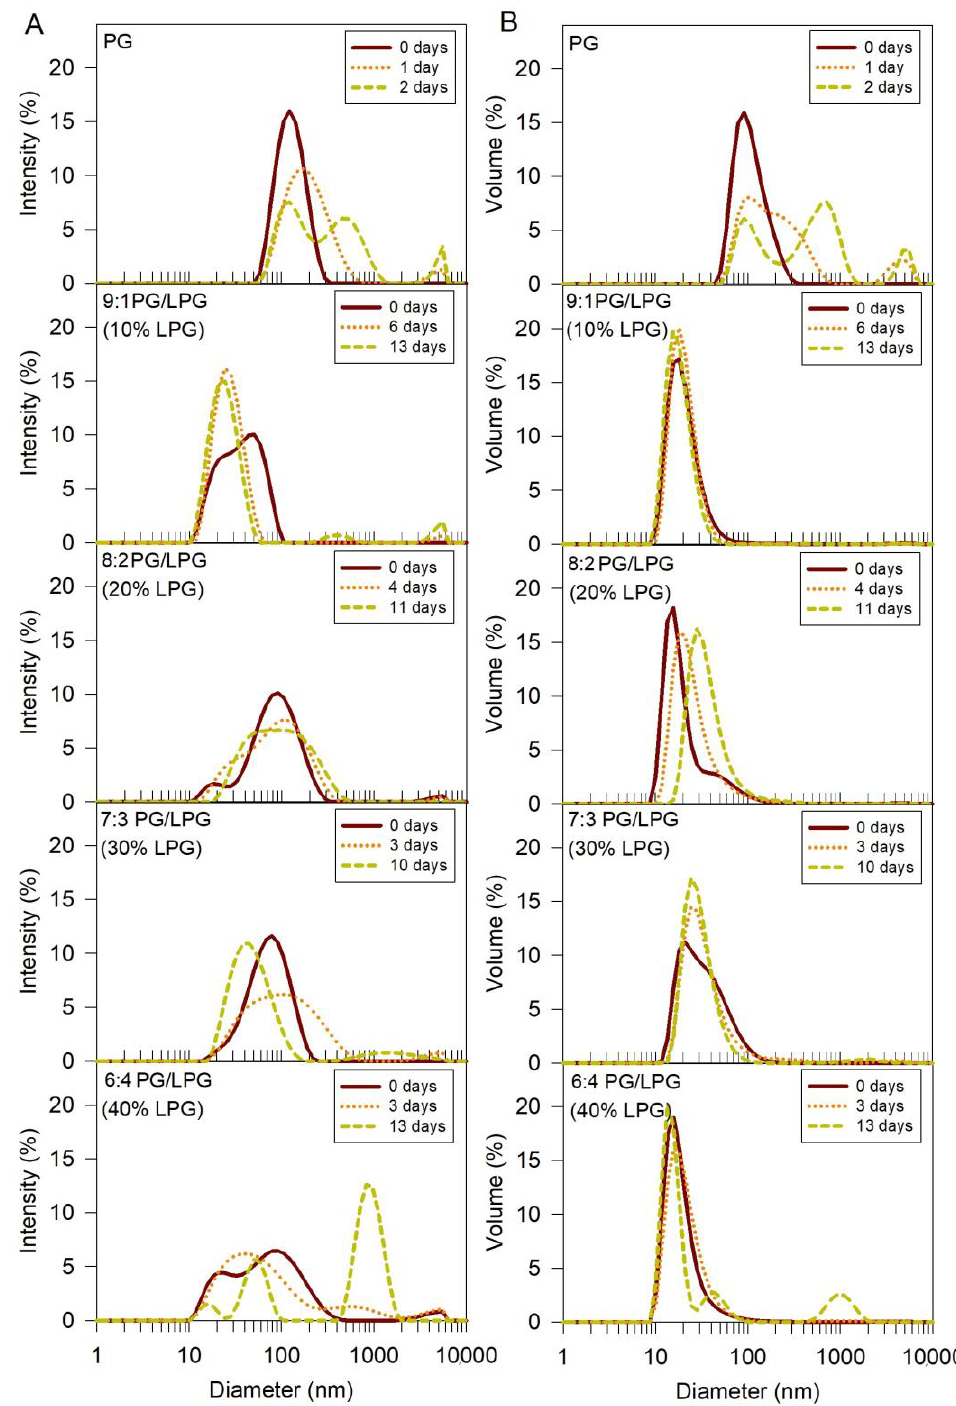
Figure 4. Size distribution of PG and PG/LPG vesicles in order of increasing LPG percentage. The intensity ( A ) and volume ( B ) size distributions were determined using DLS. Size distributions at three time points are presented for each vesicle type to observe the relative stability of the vesicles against aggregation over time.